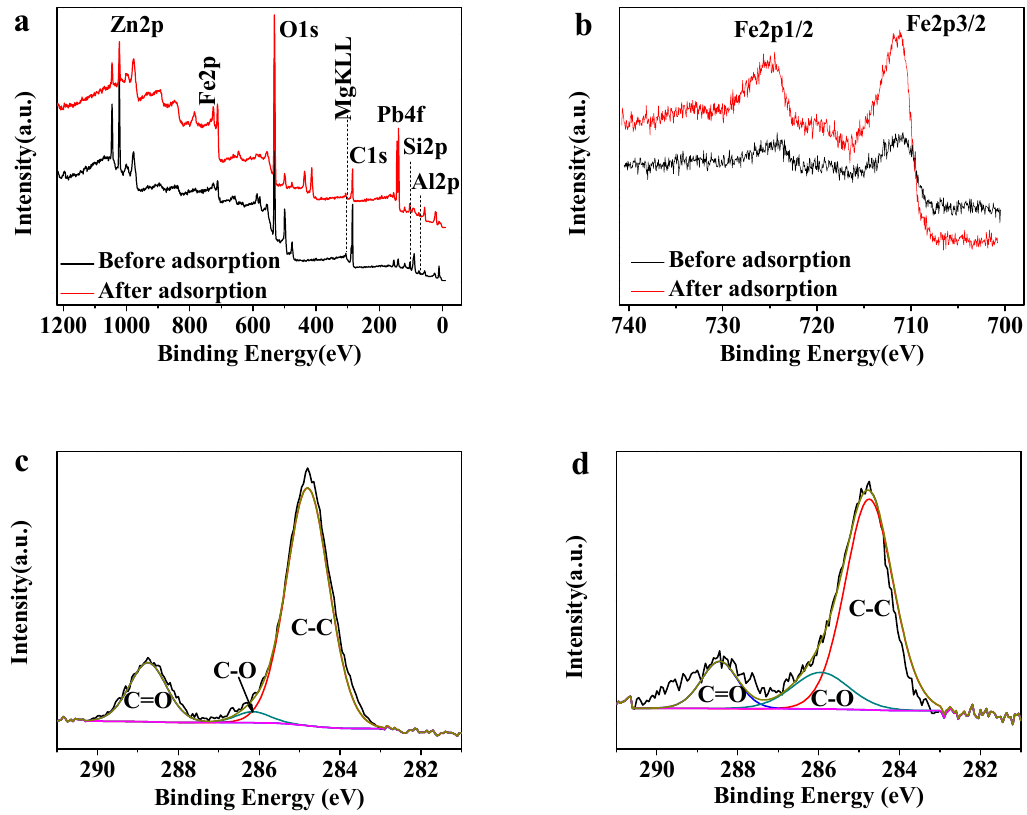
Figure 5. XPS spectra of MMMT@Zn-BDC: ( a ) wide scan, ( b ) Fe 2p; C 1s spectra of ( c ) MMMT@Zn-BDC and ( d ) MMMT@Zn-BDC loaded with Pb(II).